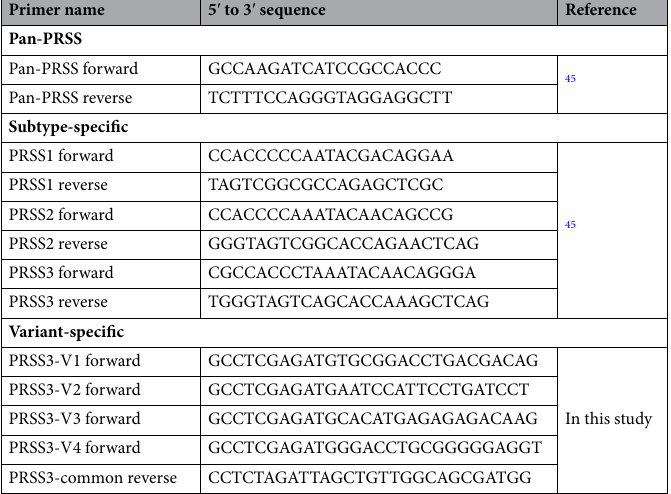
Table 2. Primers used for determination of PRSS gene